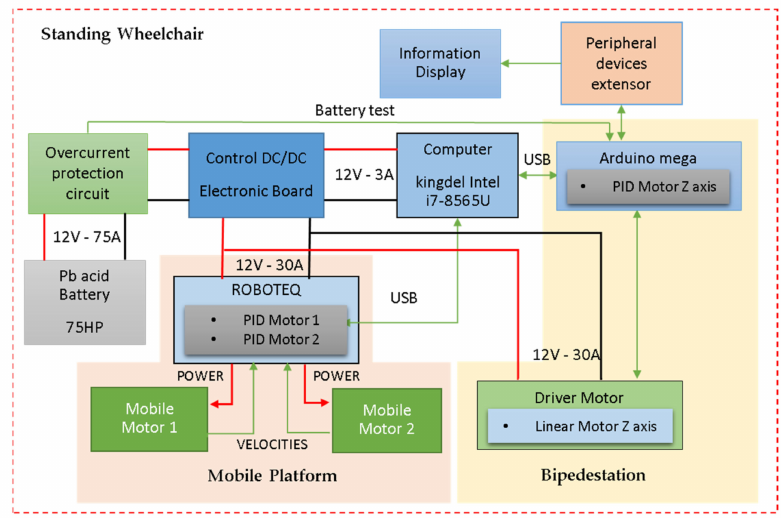
Figure 8. Design elements of the robotic standing wheelchair.